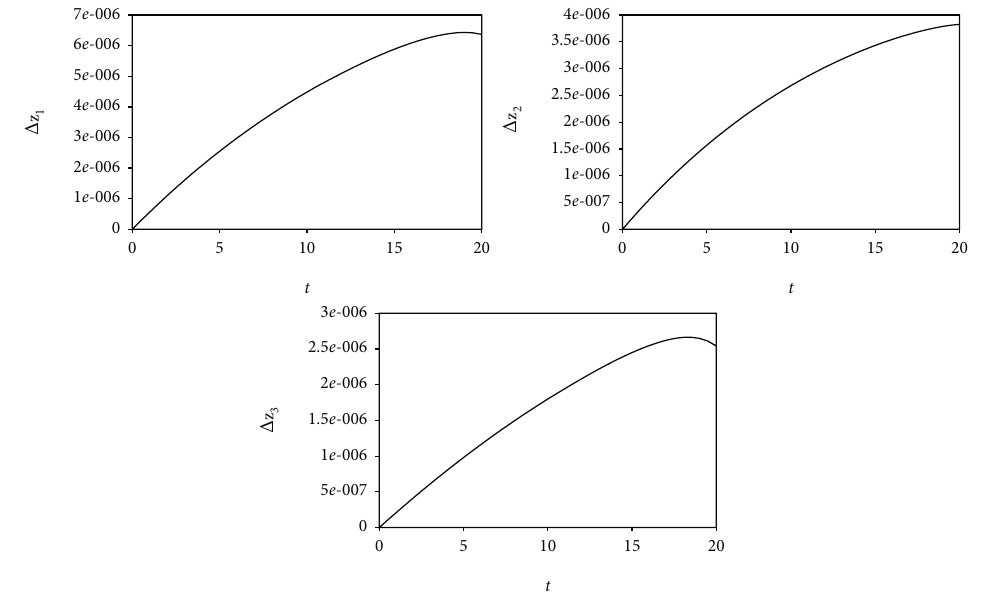
Figure 4: Absolute error (A.E.) of step input for Δ z